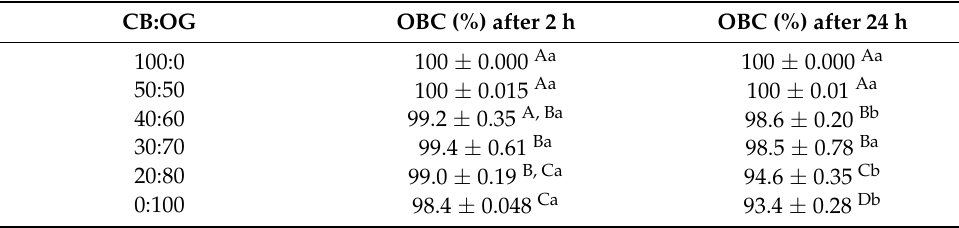
Table 5. Oil-binding capacity (OBC) for the different formulated CB:OG